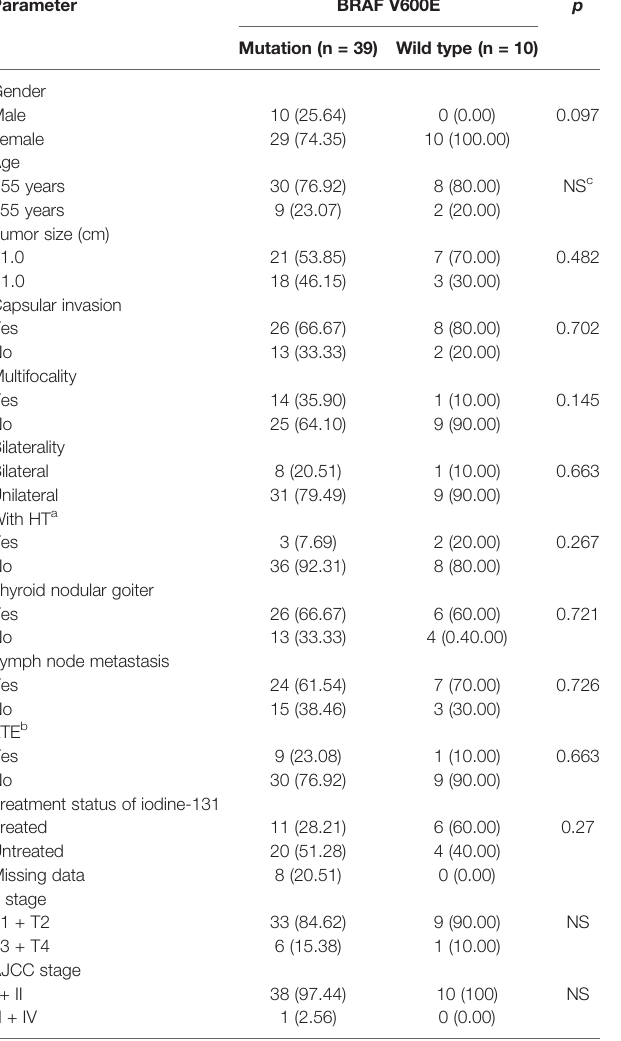
TABLE 8 | Relationship of BRAF V600E with clinicopathological factors of SNMTC, n (%). Parameter